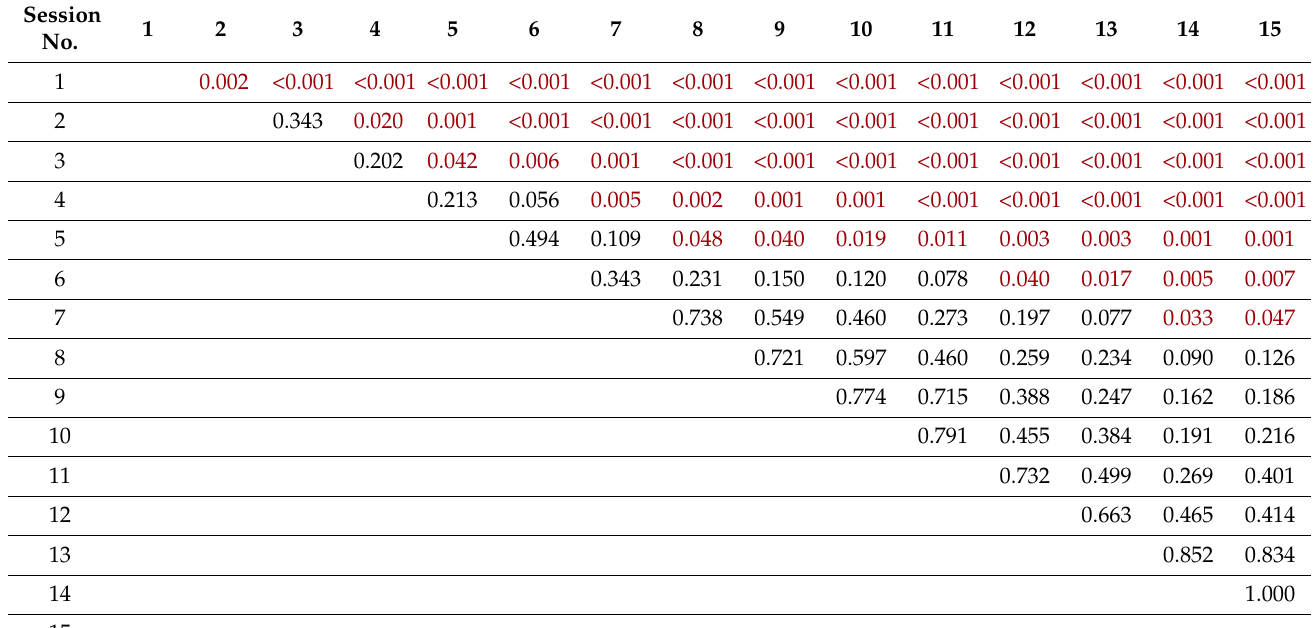
Table 4. Results of the Wilcoxon Rank Sum Test. The p -values lower than 0.05 (which means significant differences between groups) are marked in